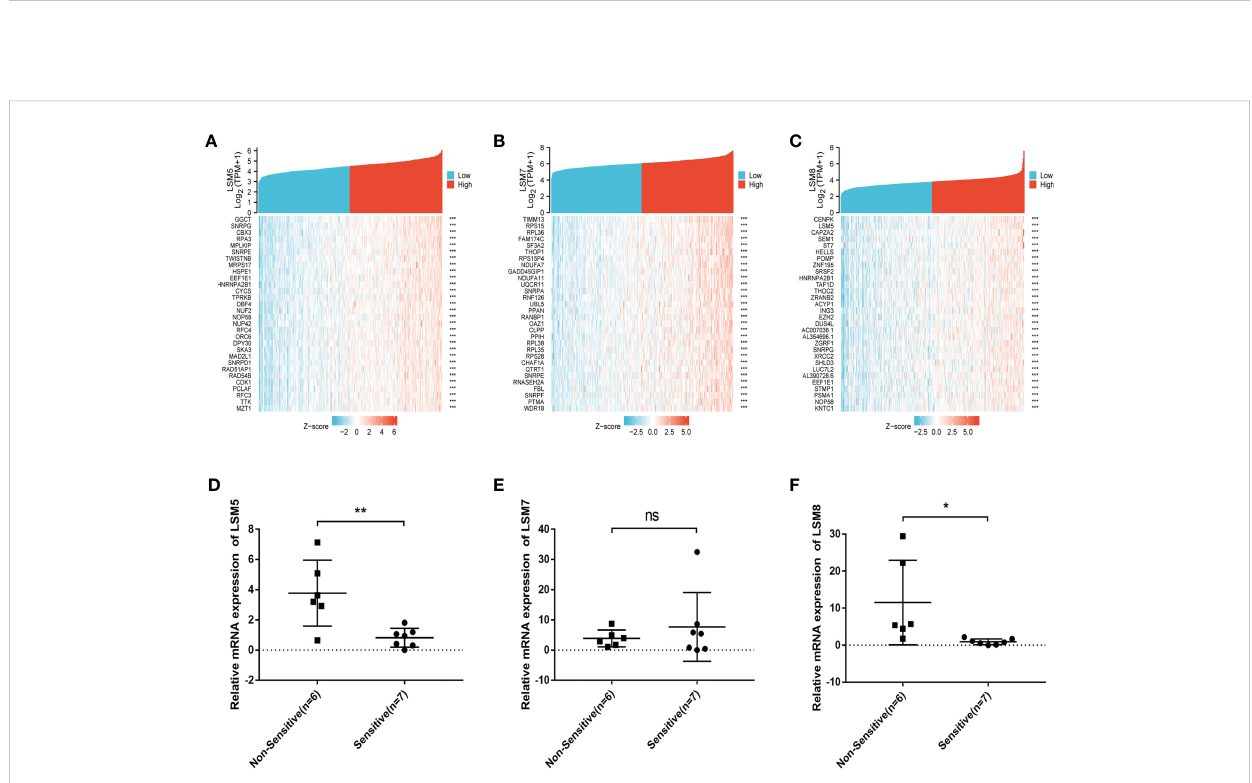
FIGURE 6 The positively correlated 50 genes and mRNA expression levels of LSM5, LSM7 and LSM8 in GC. (A-C) The gene co-expression heatmap of the top 50 genes positively correlated with the expression of LSM5, LSM7 and LSM8 in GC. (D) The mRNA expression level of LSM5 was higher in the non- sensitive group compared to sensitive group. Groups were selected by the effects of GC patients with 5-FU chemotherapy. 13 GC patients here had paired tumor and normal tissues. ns, p ≥ 0.05; *p < 0.05; **p < 0.01. (E) LSM7 had no signi fi cance betwwen two groups. (F) The mRNA expression level of LSM8 was higher in the non-sensitive group compared to sensitive group. All of above were from TCGA